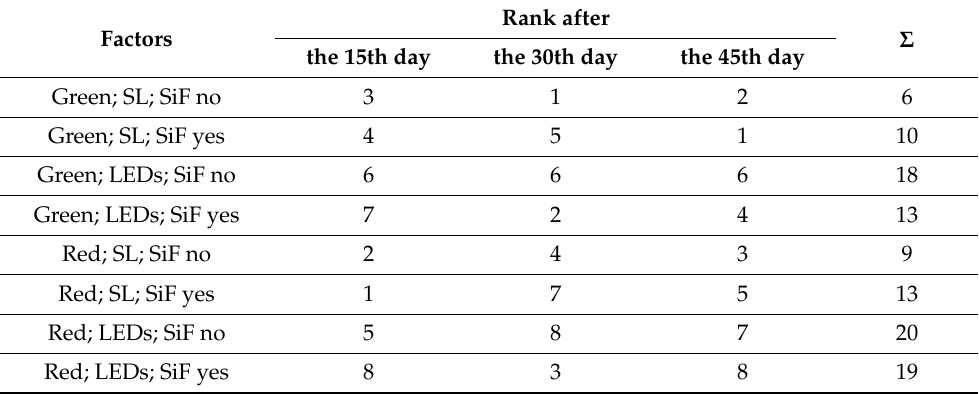
Figure 3. Comparison of the results of biometric and biochemical analysis for red and green lettuce after the 15th ( A ), 30th ( B ), and 45th ( C ) days of cultivation. The diagrams display the normalized parameters presented in Tables 1–6 (eight parameters shown in the right panel at the bottom of the diagrams). The sets of parameters corresponding to a combination of three factors—type of lettuce, type of lighting, and the use of Si fertilizer—are connected by red or green lines with markers (the left panel at the bottom of the diagrams). The rank of each set of measured parameters is shown in curly brackets. Rectangular frames indicate the best combination of parameters obtained in the experiments. Table 7. Rank of each combination of factors (plants, lighting, Si fertilizer (SiF)) after the 15th, 30th, and 45th days of cultivation and the total ranks ( Σ